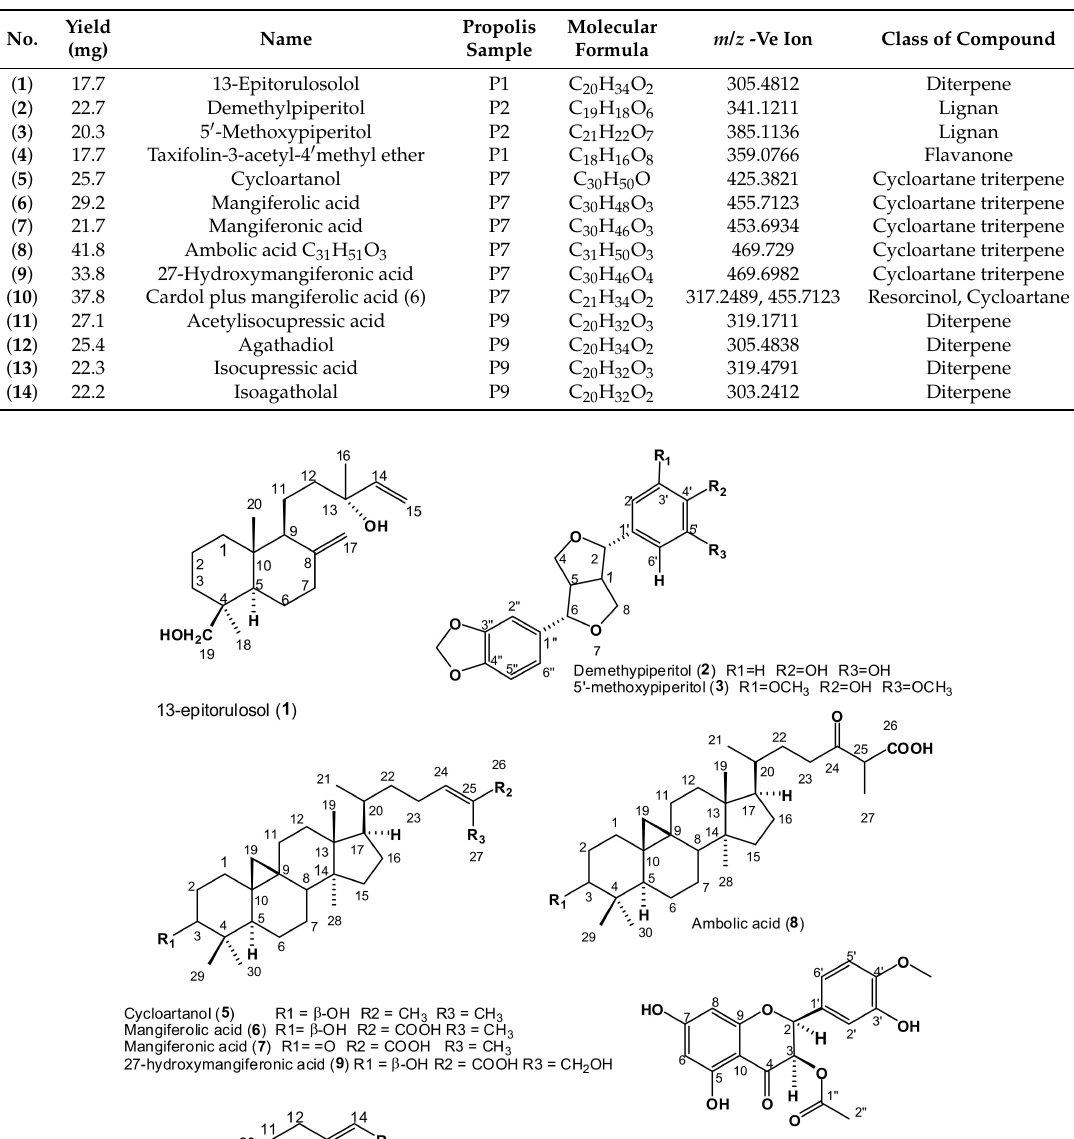
Table 3. Isolated compounds from samples P1, P2, P7 and P9.